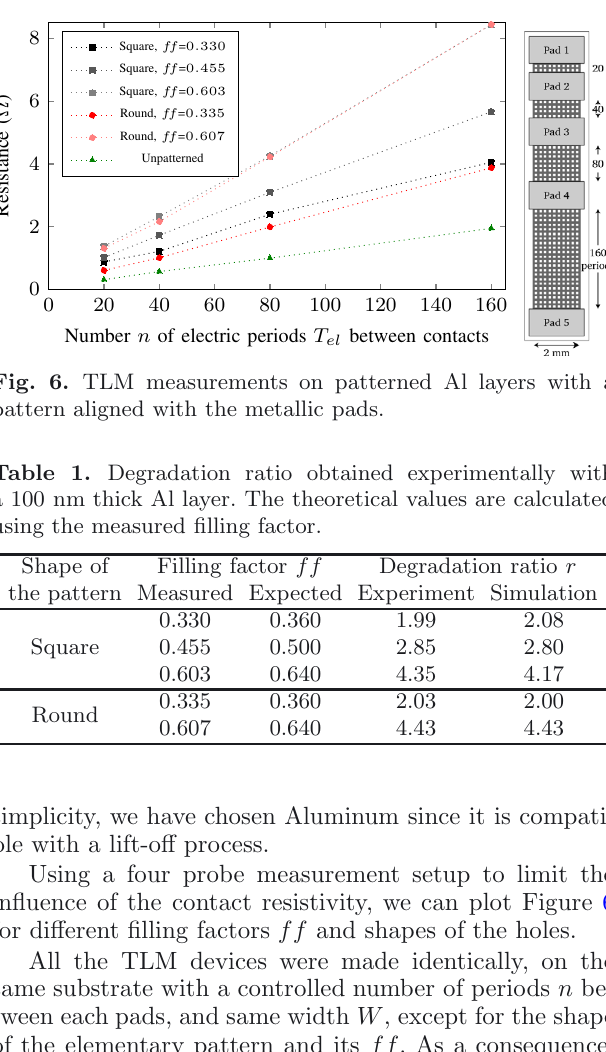
(a) Top view of the two closest metallic pads of one of the TLMs Fig. 5. Microscope views of the fabricated TLMs with different patterns and T el equal to 50 μ m. Scales for pictures in (b) and (c) are the same.